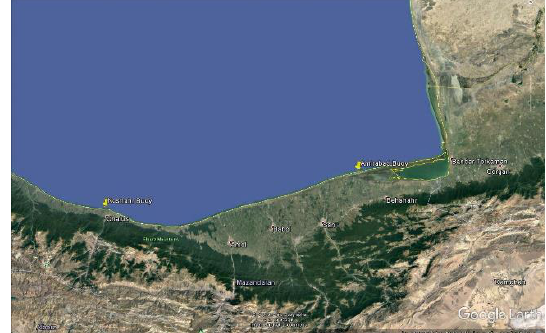
Figure 1. Buoys location which wave measurements are obtained from